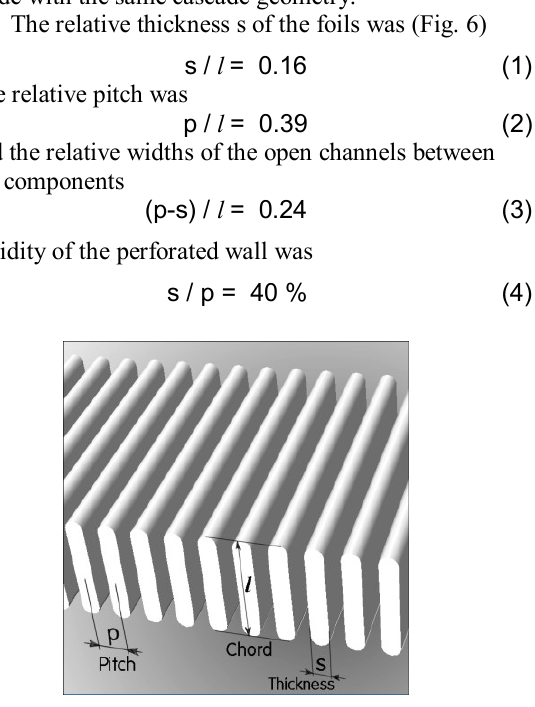
Fig. 6. Author's investigations of the jet reflection and refraction were made with the wall consisting of a cascade of rods made by flattening of what were originally round rods or